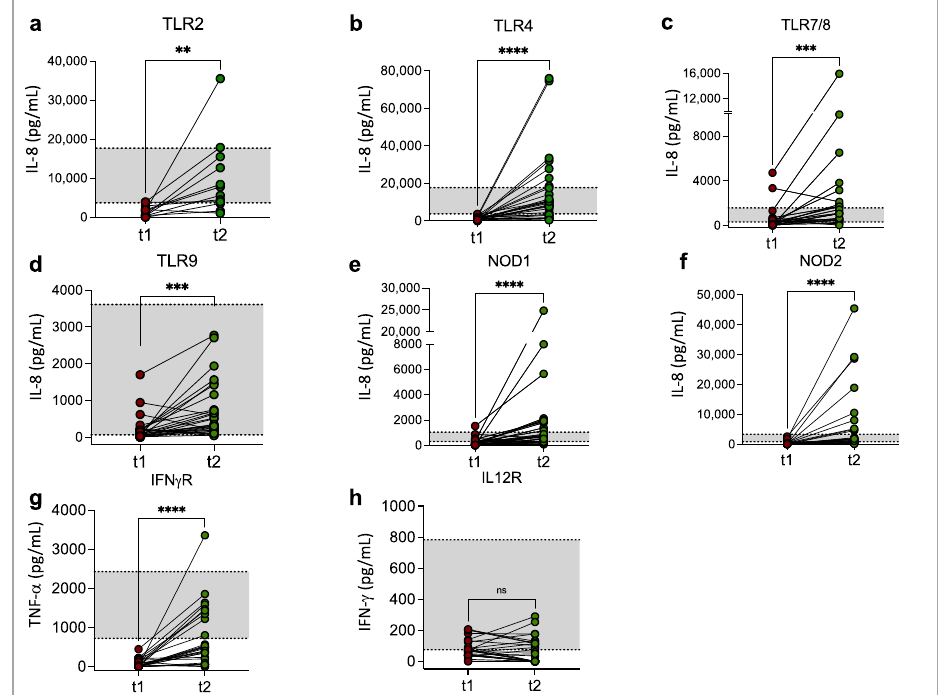
Figure 4. Individual analysis of the recovery of immune responses in COVID-19 patients. Before–after plots with the patients’ innate ( a – f ) and cytokine ( g , h ) responses at admission (t1) and two weeks later during hospitalization (t2) are depicted. Shaded areas flanked by dotted lines indicate the upper and lower limits of the 95% CI of the healthy controls’ median responses. ** p < 0.01, *** p < 0.001, **** p < 0.0001, ns = not significant.